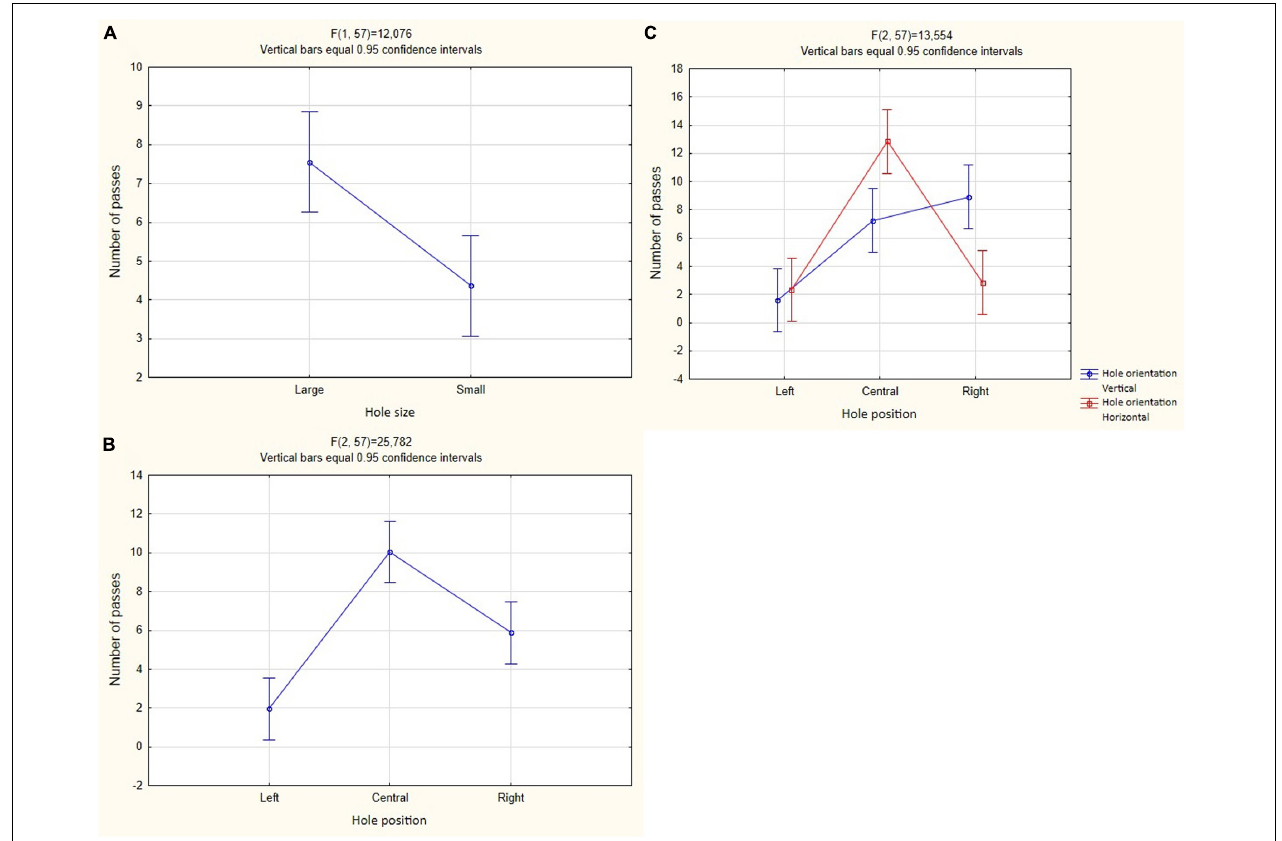
FIGURE 6 | Mean and 95% confidence intervals for the number of passes through holes in Experiment 1 in both groups ( N = 6). (A) Is the predictor of the hole size; (B) hole position predictor; (C) mutual influence of predictors of hole orientation and hole position.